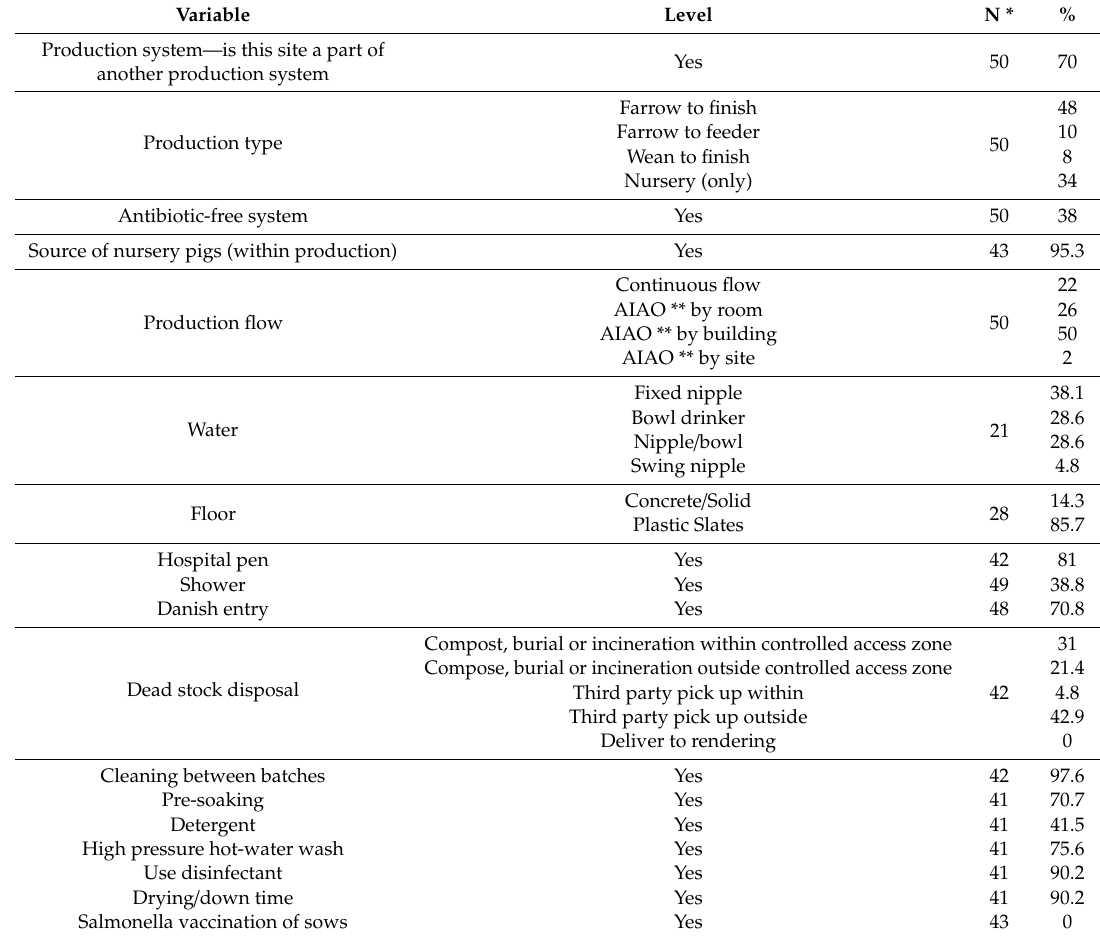
Table 1. Distribution of cohort-level risk factors (farm management and biosecurity) in 50 swine nursery cohorts (44 farms; 6 farms where a second cohort was conducted). Variable Level N *